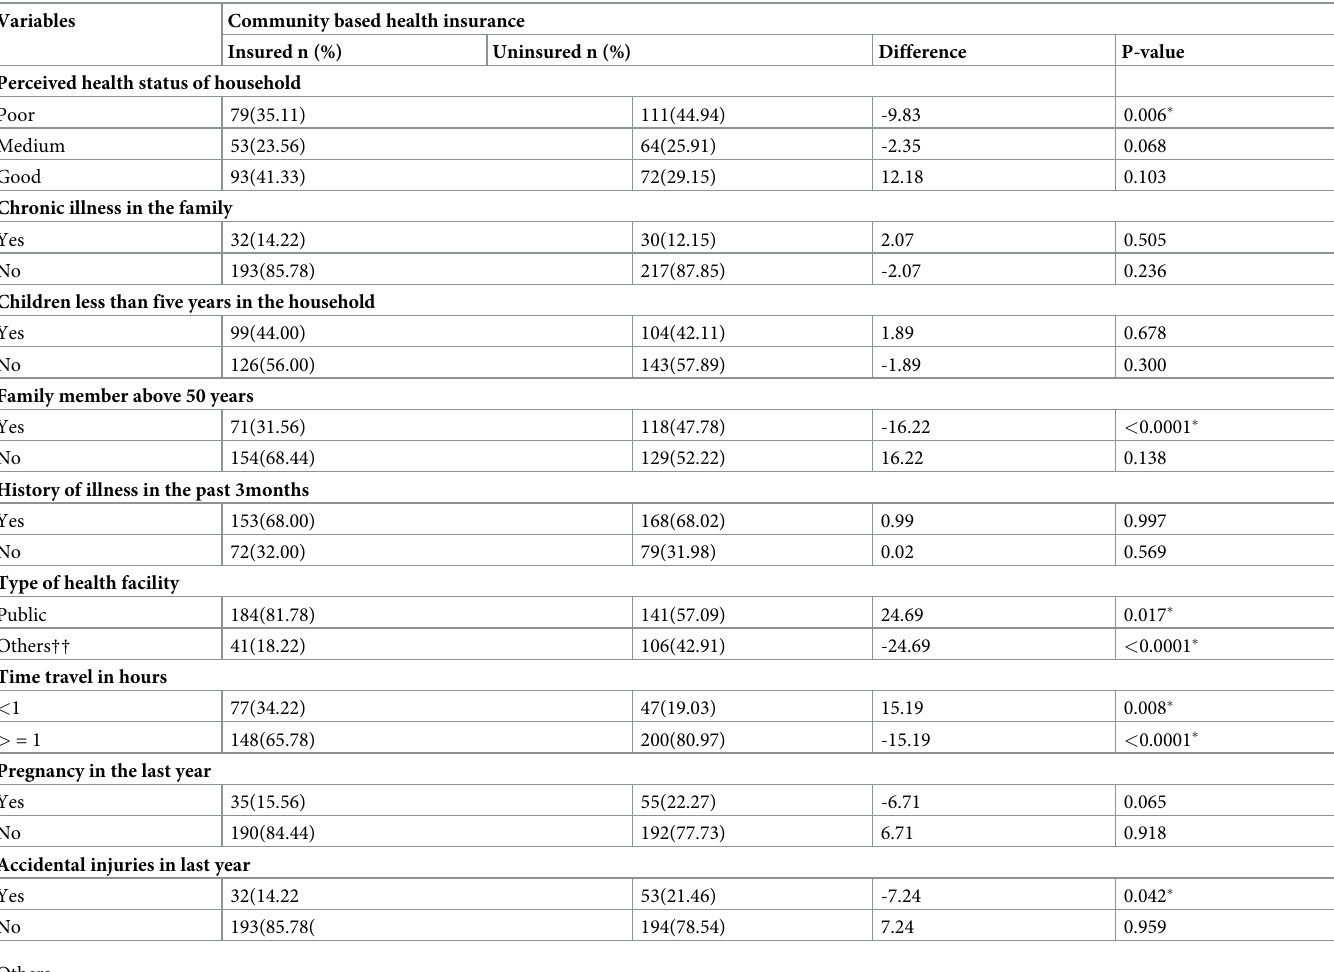
Table 2. Health and health- related factors among insured and uninsured households in Kutaber district, Ethiopia, 2020 (n = 472). Variables